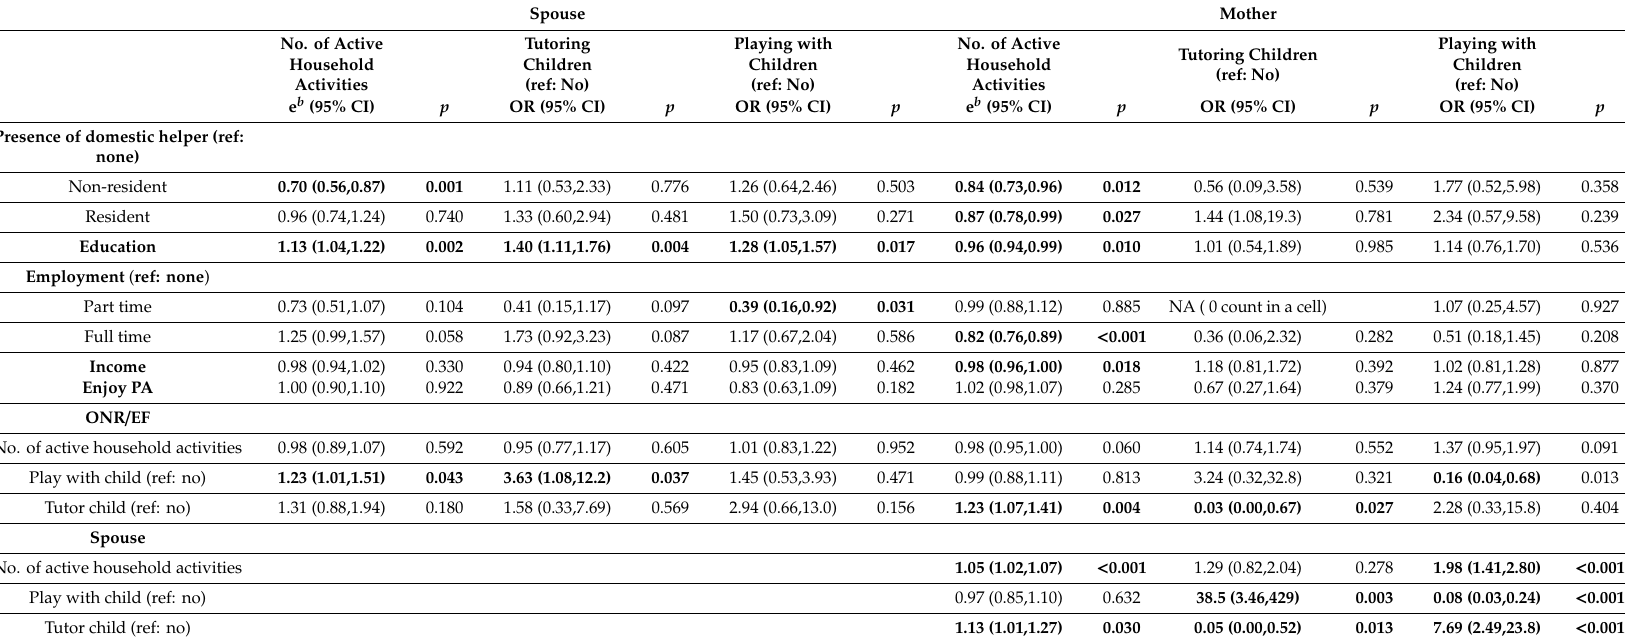
Table 5. Associations of mothers’ socio-economic status indicators, presence of a domestic helper and household activities undertaken by other non-residents / extended family members with household activities undertaken by spouses and mothers a (Steps 2 and 3 of mediation